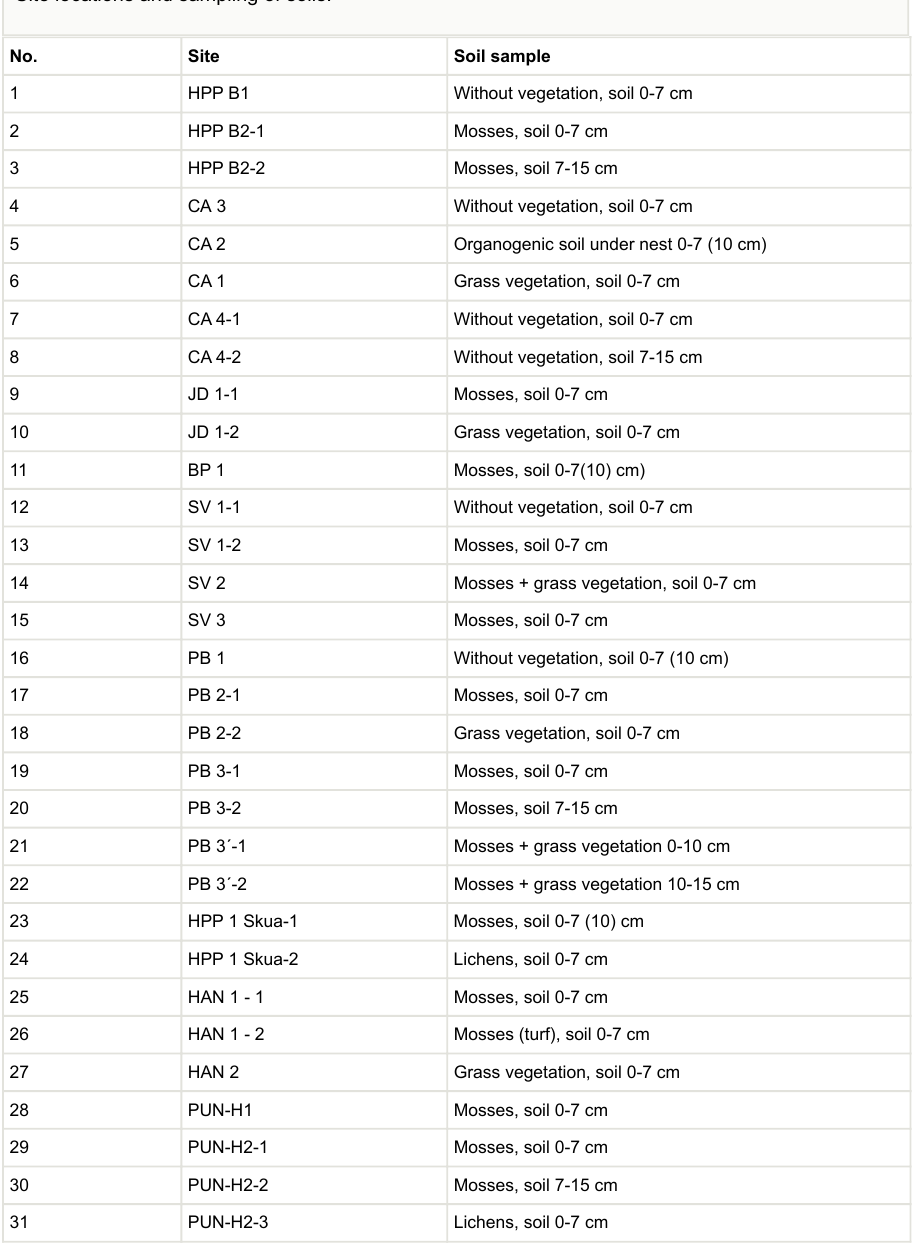
plastic bags in January 2019. The description of sites with an indication of the sampling design are presented in Table 1. Table 1. Site locations and sampling of